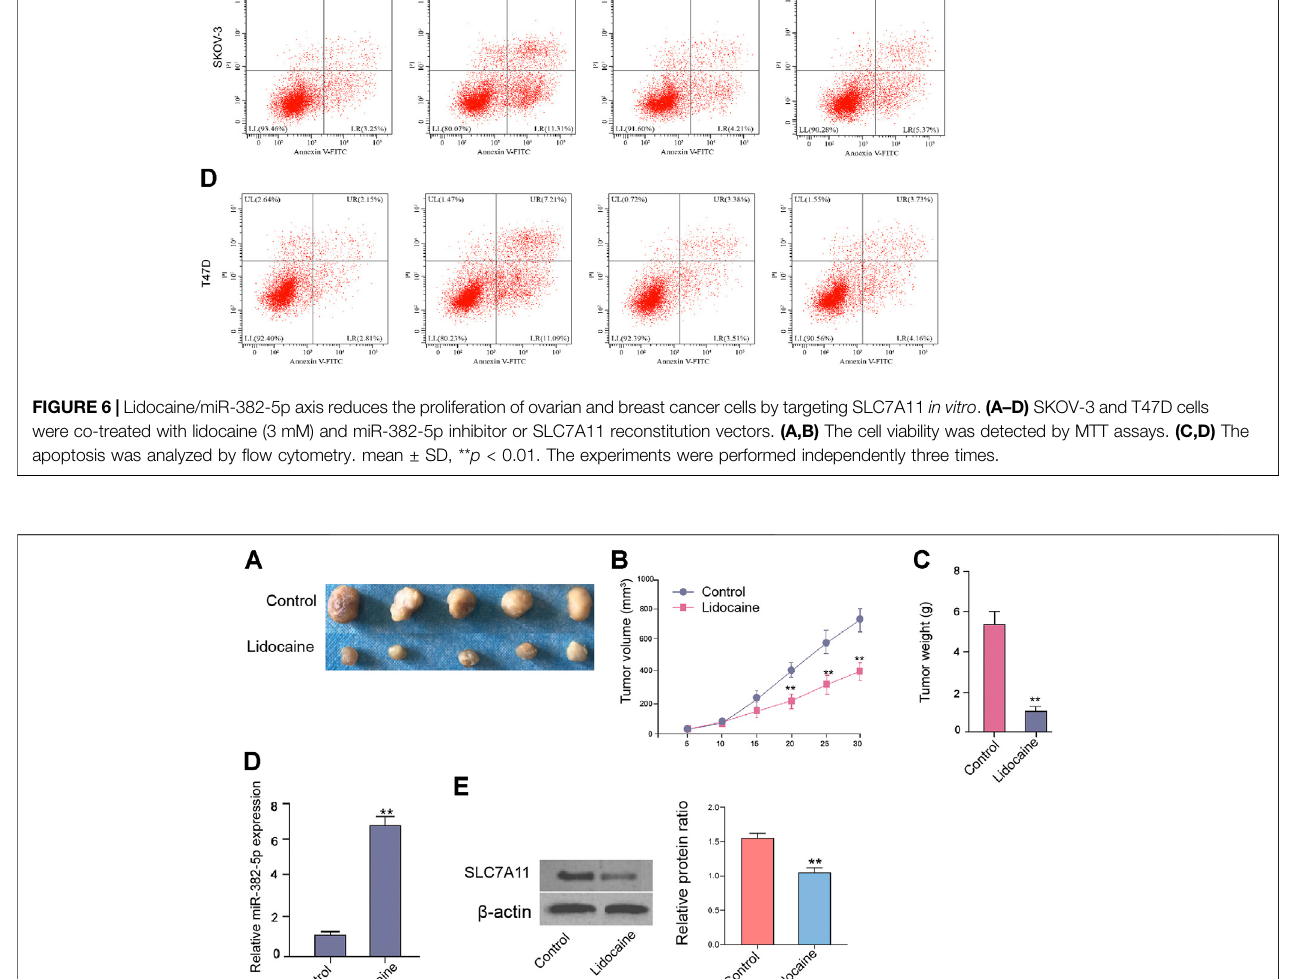
Frontiers in Pharmacology |